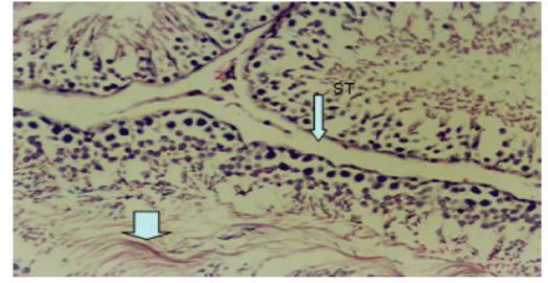
Fig. 6. Testes of male rats treated with lead acetate and vitamin E showing mild degenerative changes of seminiferous tubules (ST), mild congestion (thin arrows) and edema (hollow arrows) (H&E X 200)